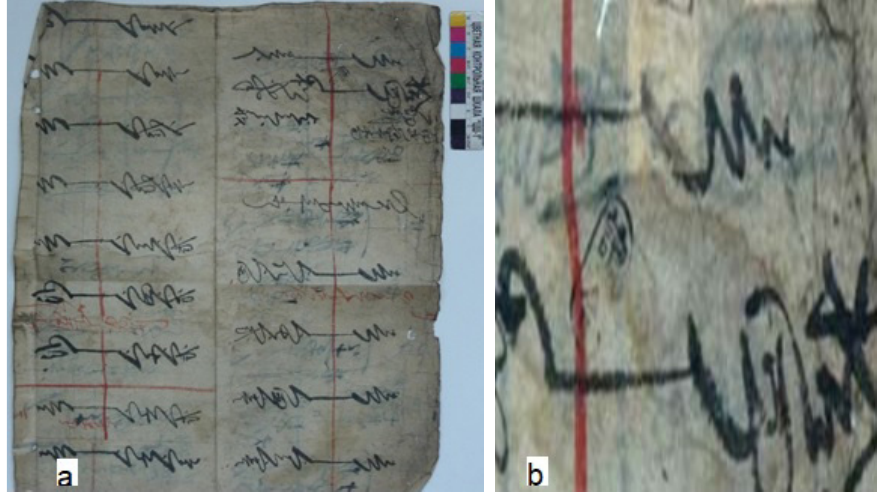
Figure 7. Images of a sheet of medieval Arabic manuscript: ( a )—a general view, ( b )—a fragment (a light rectangle in the middle at the top) cleaned by a laser.